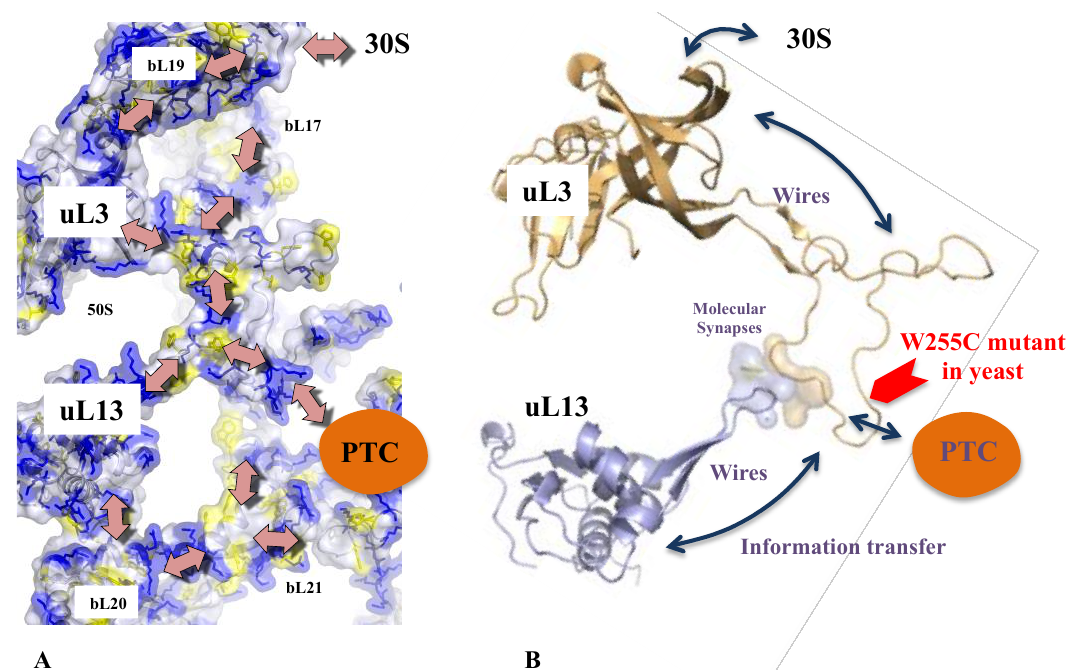
Figure 6. The possible communication pathways along the r-proteins located around the PTC. ( A ) The view of the r-proteins are represented by transparent surfaces coloured according to the amino acids; yellow: aromatic amino acids; blue: basic amino acids. ( B ) The same view without the surface focused on the universal uL3–uL13 interaction. The tiny interface uL3–uL13 is represented by transparent surfaces. The position of the mutant W255C that causes translation defects in yeast is indicated by the red arrow.